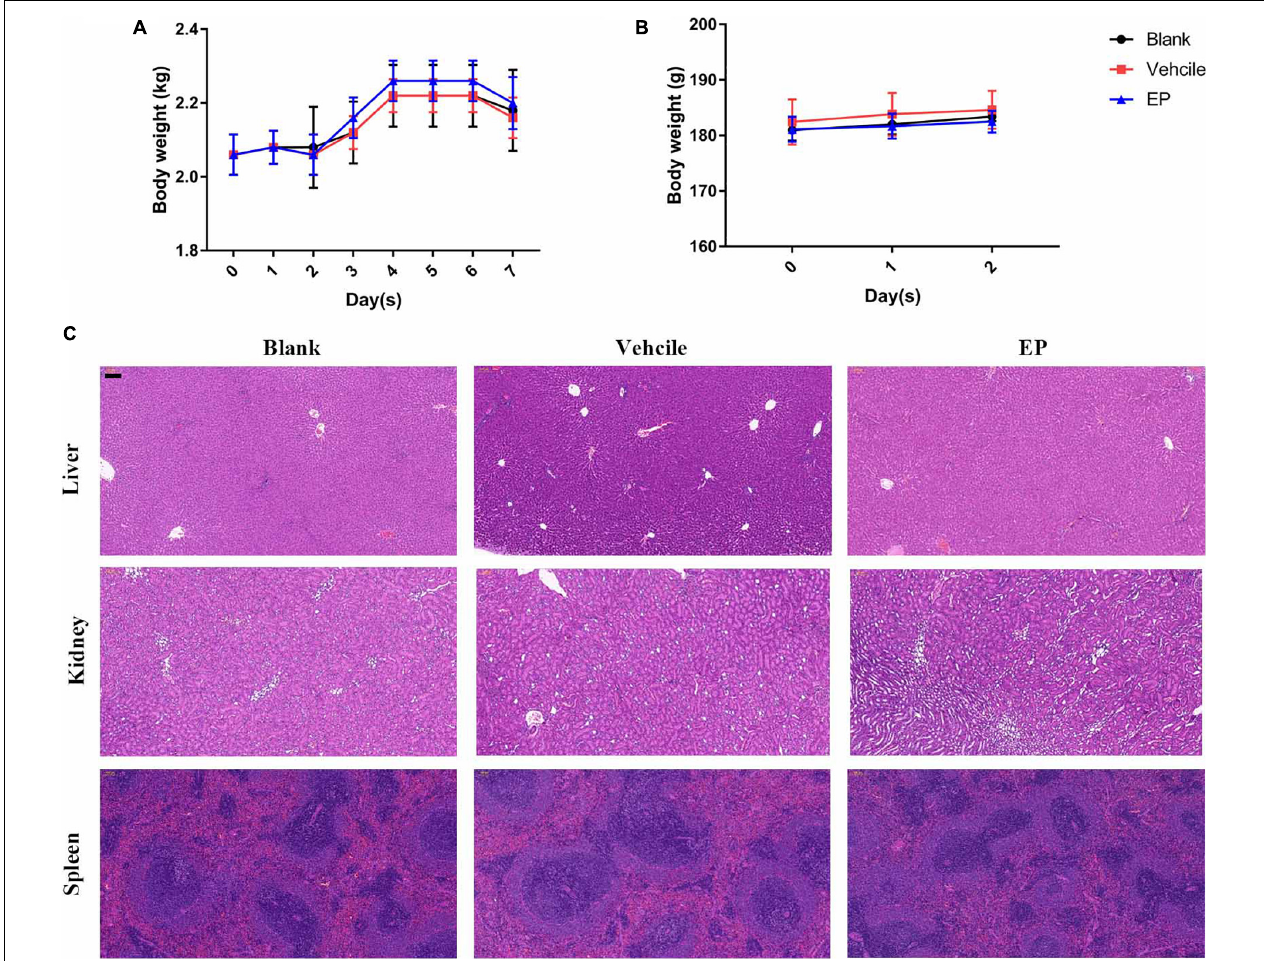
FIGURE 7 | In vivo toxicity of EP. (A) Body weights of New Zealand rabbits during EP treatment in a skin infection model for seven days. (B) Body weights of rats after treatment with 15 mg/kg of EP (I.P.) for 3 consecutive days. (C) No signs of hepatic, renal, or splenic toxicity were observed in rats by H&E staining. Six rats per group were treated with blank (saline, I.P.), control (5% Kolliphor + 5% ethanol, I.P.), or EP (15 mg/kg, I.P.) every 12 h for a total of 3 days. After the last treatment dose, blood was collected, and the mice were euthanized. The organs were excised and stained with H&E